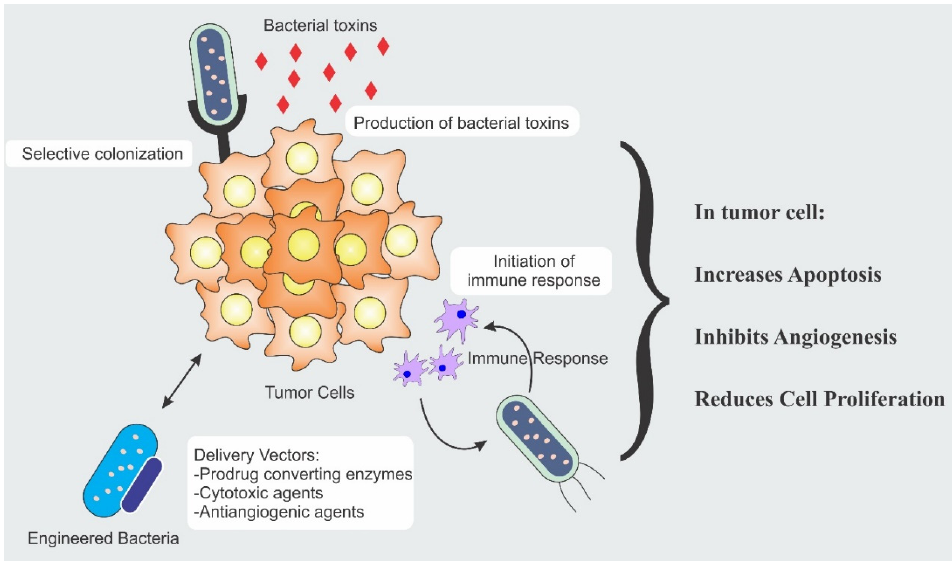
Figure 1. Bacterial therapeutic mechanisms involved in tumor eradication.